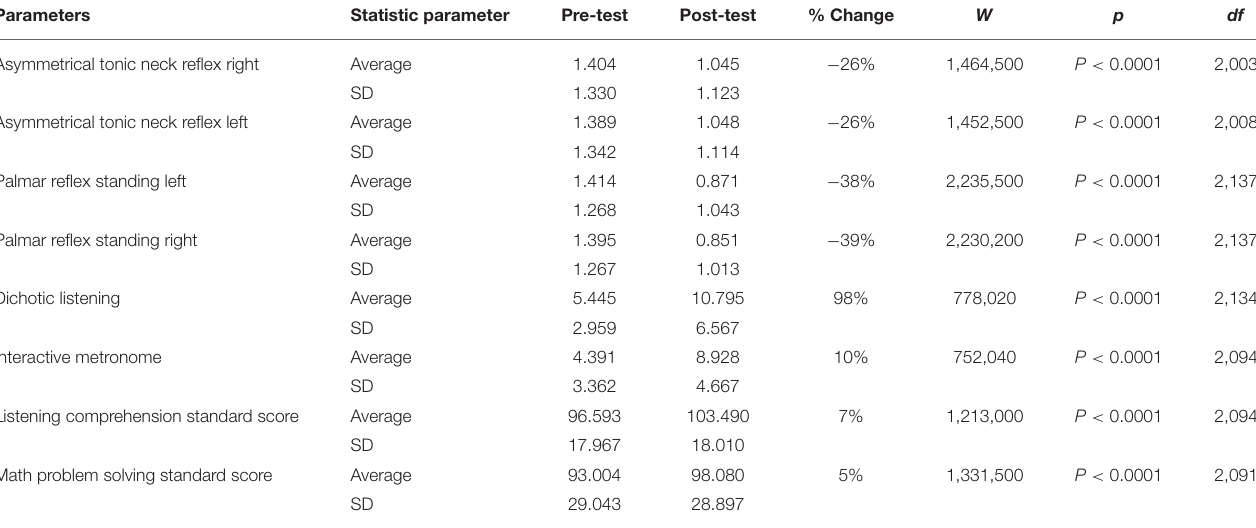
TABLE 1 | Wilcoxon rank-sum test with continuity correction.